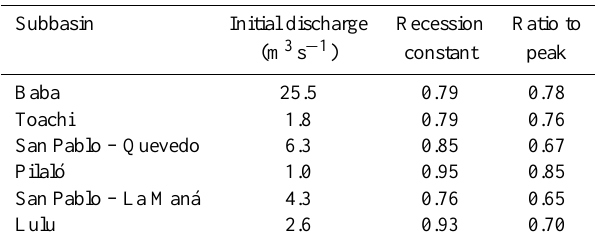
Table A2. Baseflow parameters for the Vinces River model in HEC- HMS.